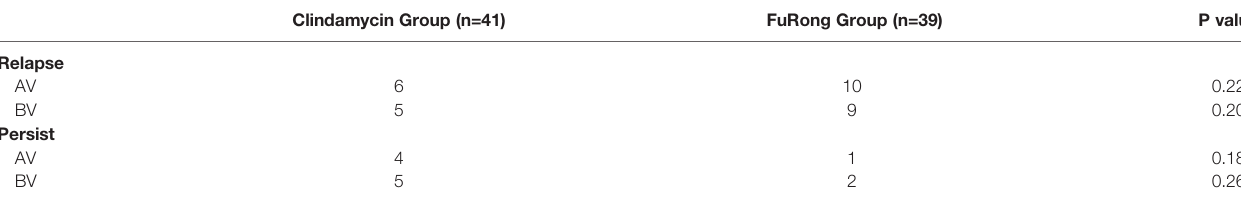
TABLE 5 | Recurrence and persistence 28 ± 3 days after